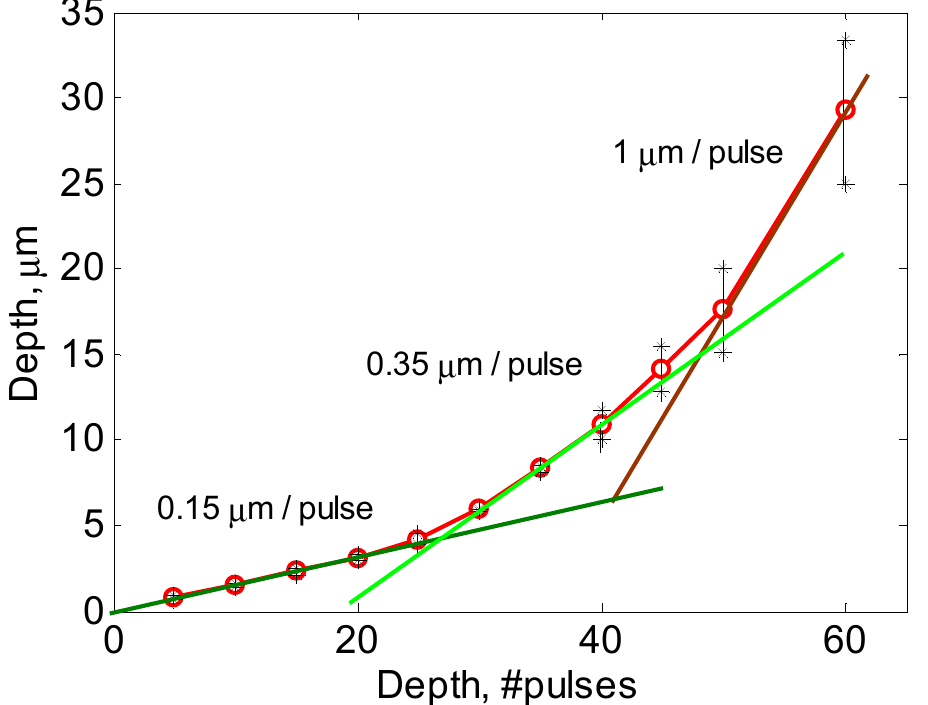
Figure 3. Calibration of ablation depths of eight printed papers. In the figure, the number of laser pulses, shown along the x -axis, and penetration depths in µ m, along the y -axis, obtained from optical profilometry are depicted. For each material layer, the toner (dark green), the coating (light green) and the base paper (dark red) characteristic ablation efficiency was evaluated (see text). Each experimental point represents an average from 15 independent measurements. Standard errors were determined to be below 10% at each depth point.